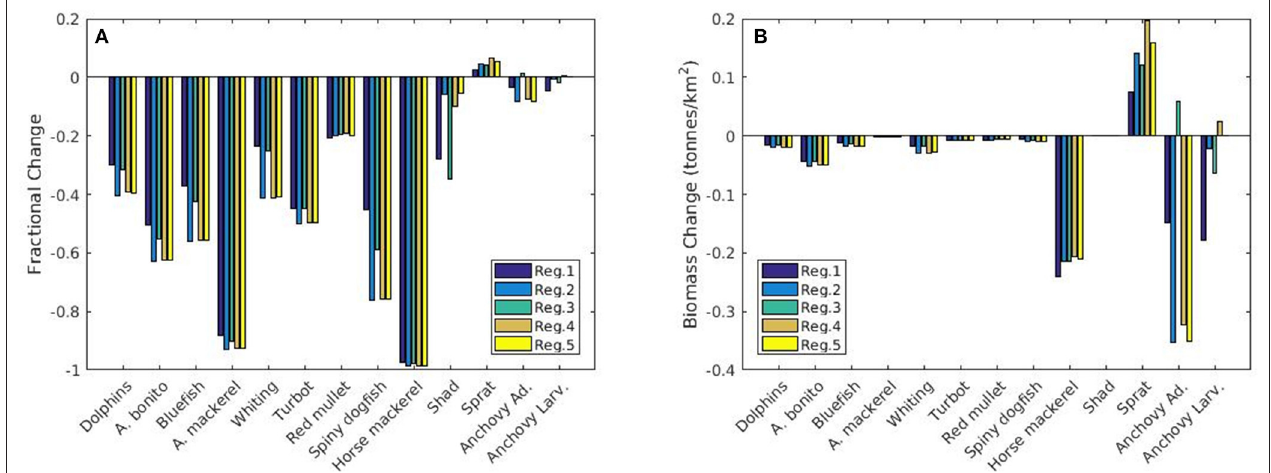
FIGURE 12 | (A) Fractional and (B) absolute change in biomass (tonnes km − 2 ) of different fish species for the five different regions of interest between the present (2010–2014) and future (2015–2020) periods. Negative values mean a decrease in biomass for the years